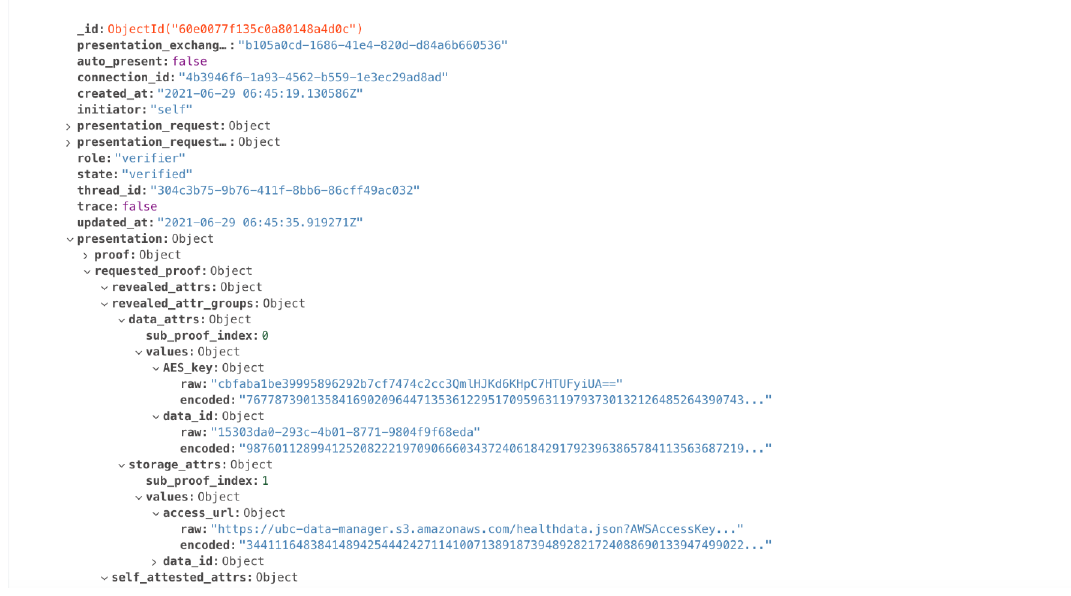
Fig. 13. The storage proof presentation.